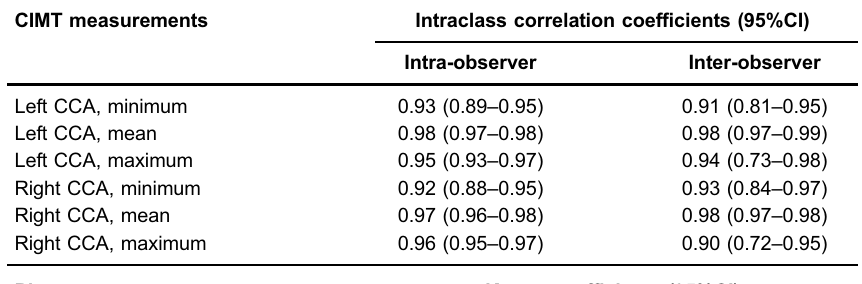
Table 1. Intraclass correlation and kappa coef fi cients (95%CI) for intra- and inter-observer agreement in carotid intima-media thickness (CIMT) and plaque